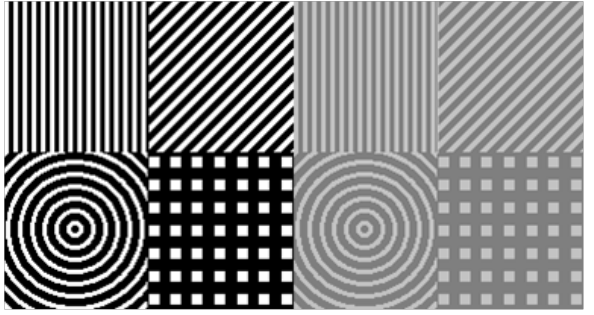
Figure 3. An artificial detailed speckle-free test image